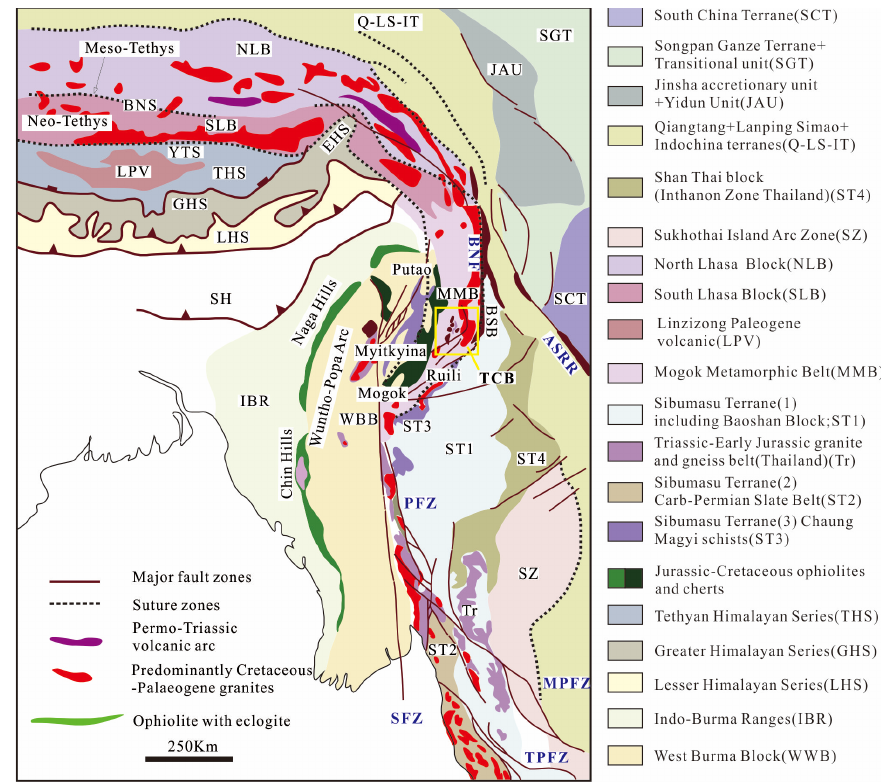
Figure 1. Simplified geological map of the Eastern Tethys (modified from [16]). Abbreviations: BNS—Bangong-Nujiang Suture; YTS—Yarlung Tsangpo Suture; BSB—Baoshan Block; BNF—Bangong–Nujiang Fault; ASRR—Ailao Shan–Red River shear zone; SCT—South China Terrane; EHS—Eastern Himalayan Syntaxis; SH—Shillong plateau; SFZ—Sagaing Fault Zone; TPFZ—Three Pagodas Fault Zone; MPFZ—Mae Ping Fault Zone; PFZ—Paung Laung Fault Zone.